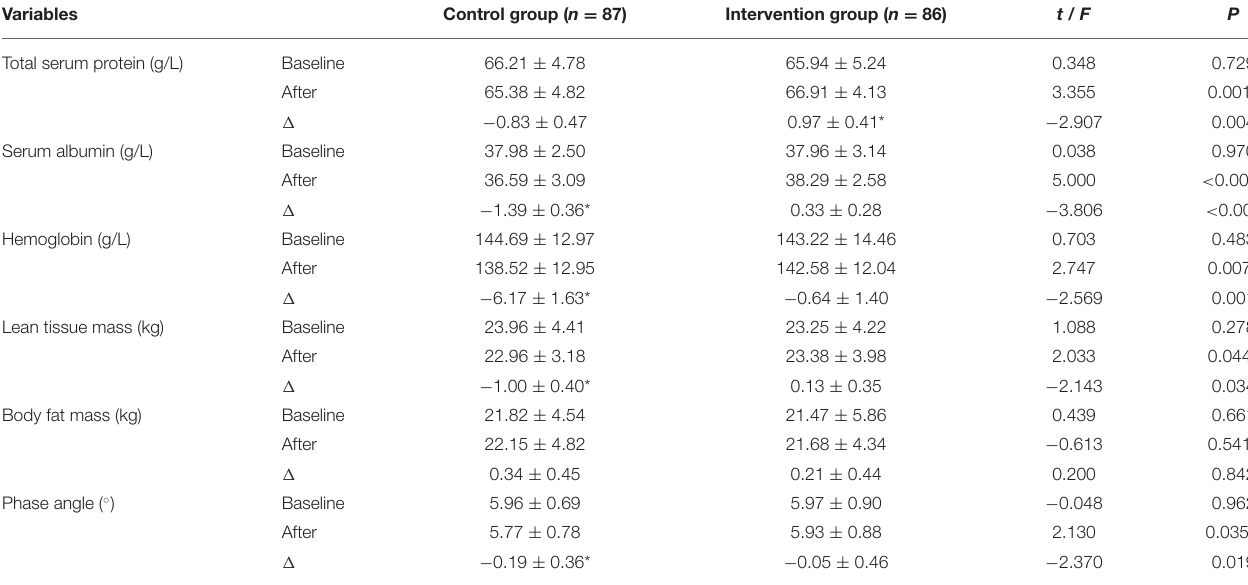
TABLE 3 | Baseline values and changes in biochemical parameters and body composition after intervention in the two